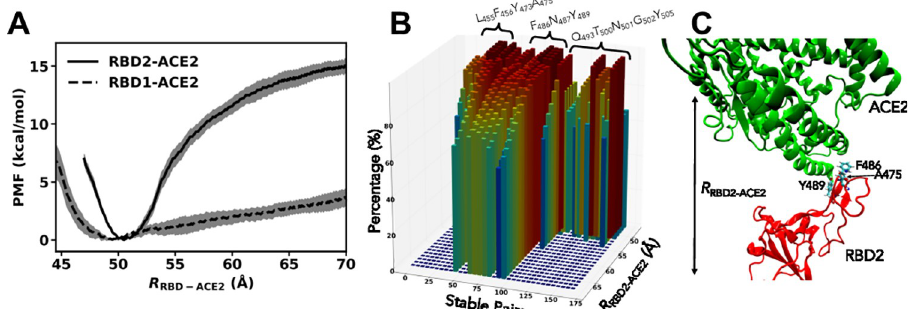
Fig 4. (A) Free-energy profiles computed from US simulations as function of R RBD-ACE2 using C36-FF. (B) Three- dimension distributions of the stable pairs (refer Fig 2) as function of the biasing distance between the centers of mass of RBD2 and ACE2. (C) A snapshot during the Umbrella simulations using R RBD-ACE2 = 70 Å . Residue A475 in RBD2 is located right behind